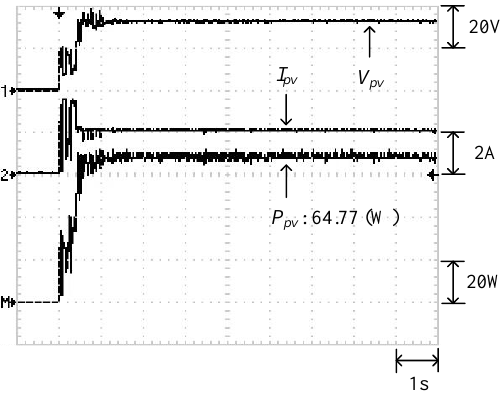
Figure 20. Maximum power point of Case 4 determined through the modified PSO algorithm.